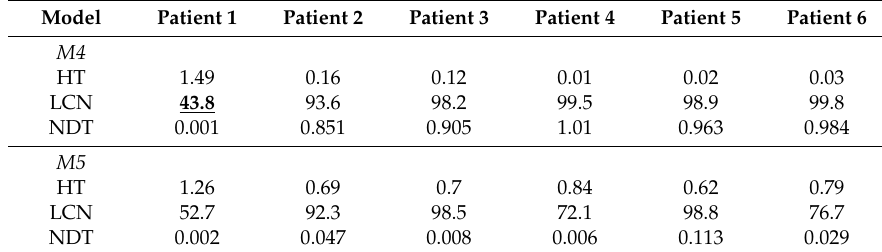
Table 2. Hepatocyte turnover (HT), (%) Lowest liver cell number (LCN), non-destructive turnover (NDT) under models M4 and M5 . Here, LCN represents the lowest liver cell number as a fraction of H during the process of infection clearance and NDT denotes the number of cured hepatocytes measured in original hepatocyte number equivalents. The critical threshold of the liver cell number to maintain liver integrity is 52%. Bold and underlined figures represents the case of liver-destruction and/or non-functionality of the